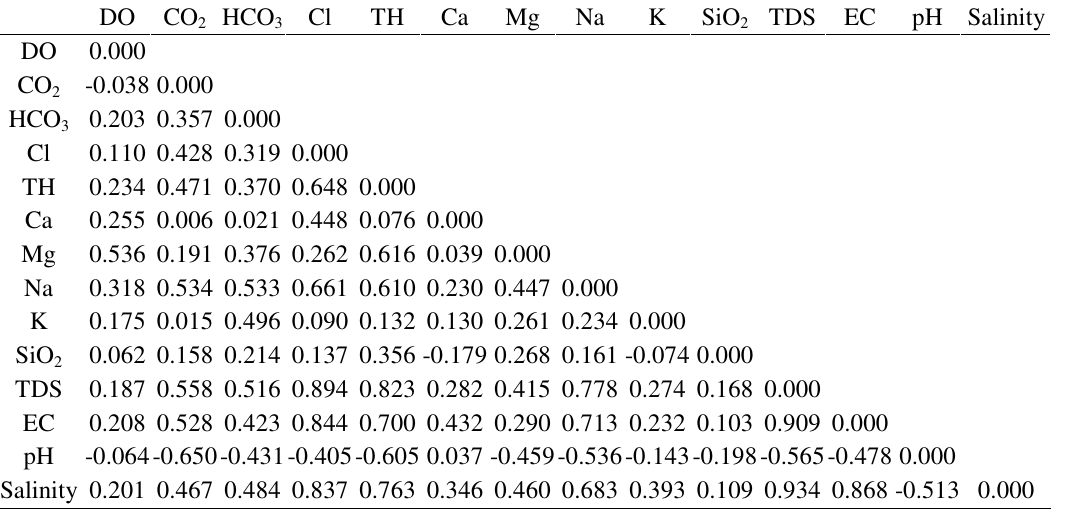
Table 5. Correlation coefficient matrix of hydrochemical data of